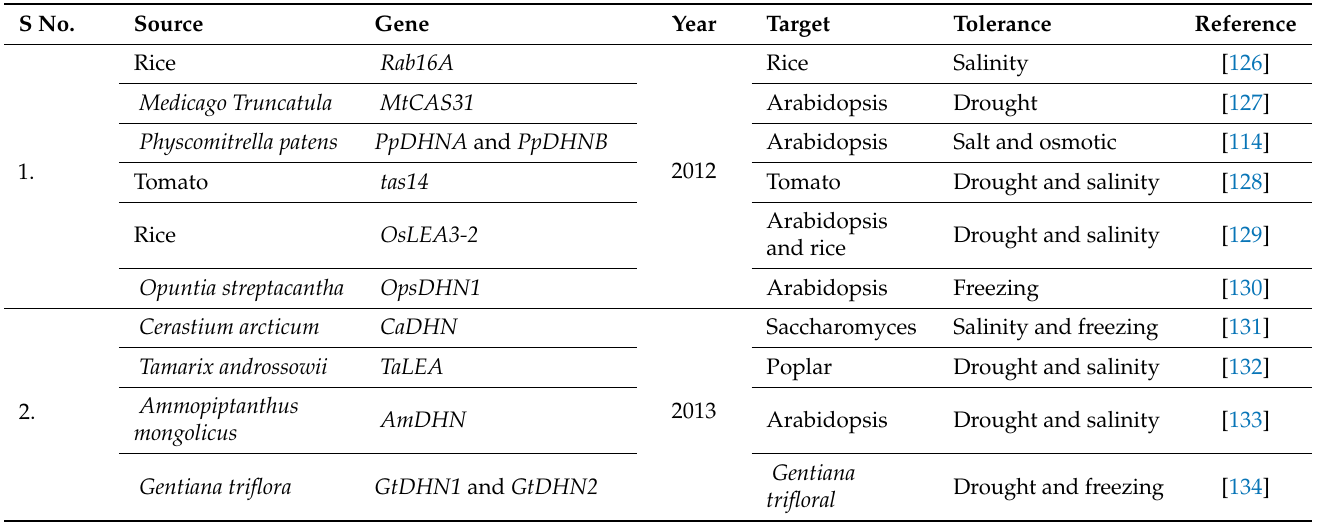
Table 1. An overview of recent advancements in knowledge of DHN gene functioning against various abiotic stresses. S